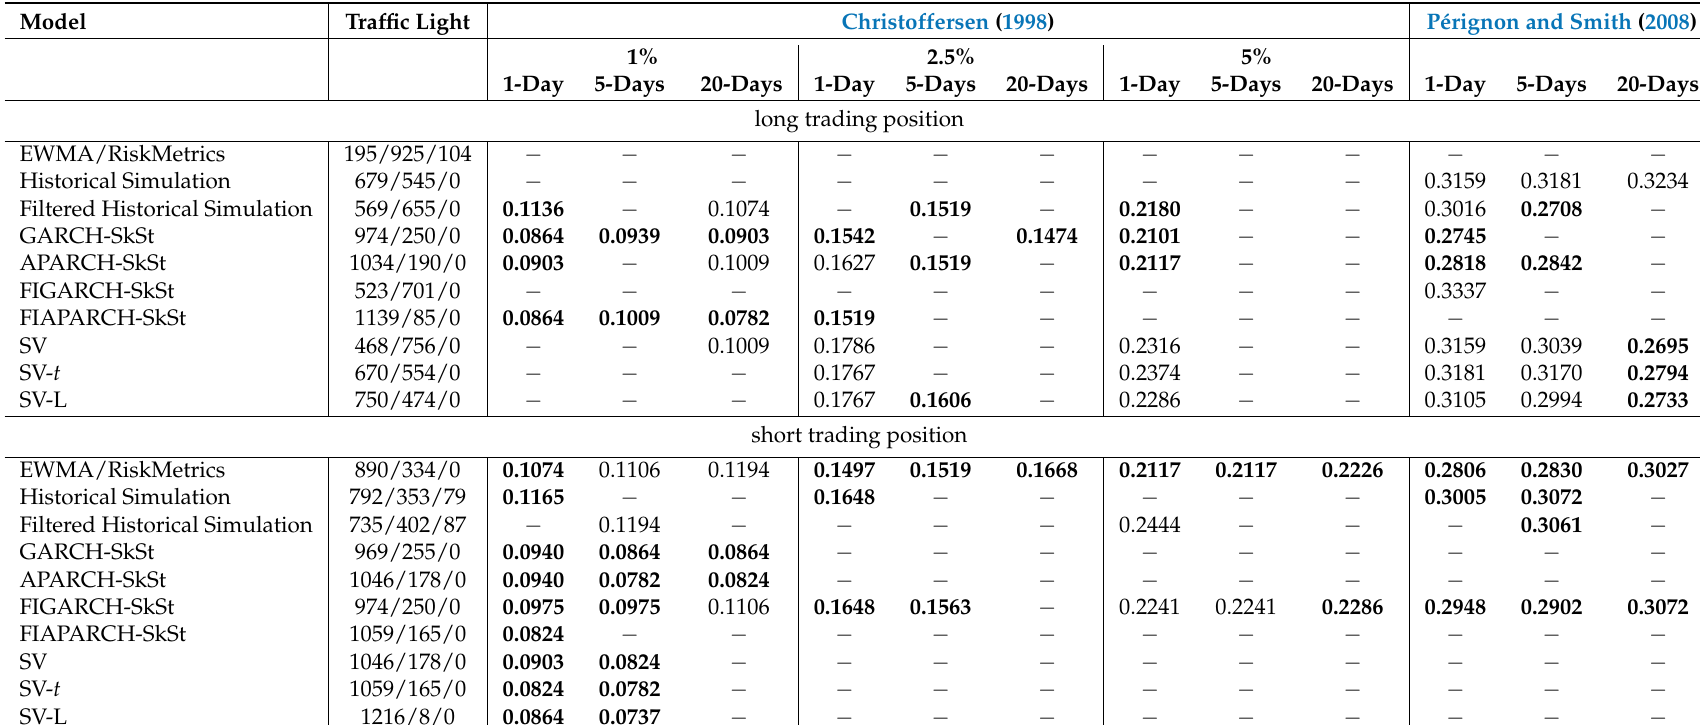
Table 3. Value-at-Risk backtest results for KLSE